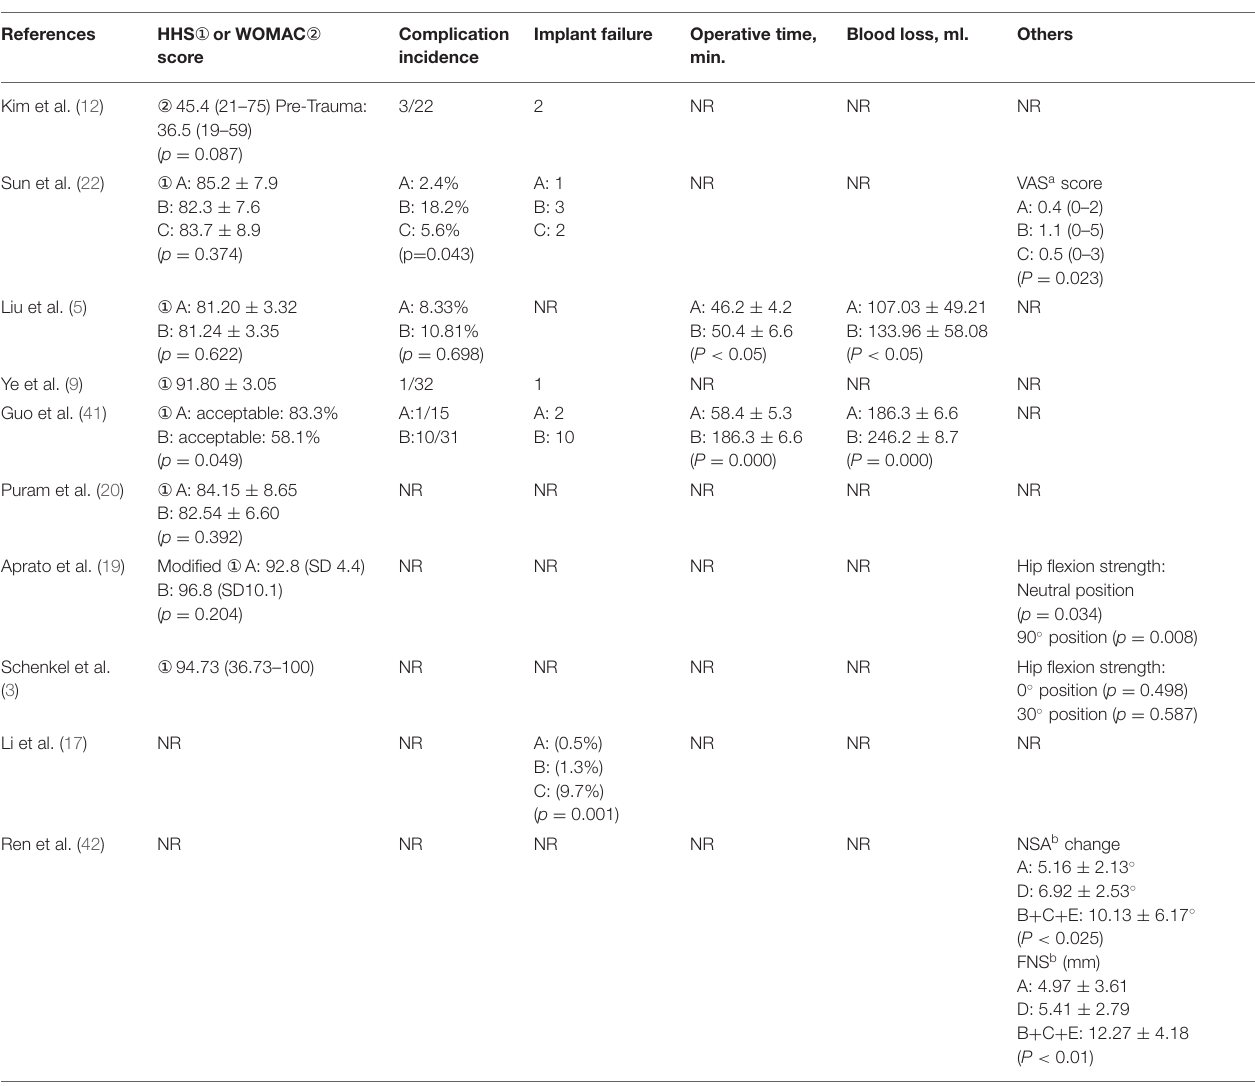
TABLE 2 | Characteristics of outcomes of reducing and fixing lesser trochanter.